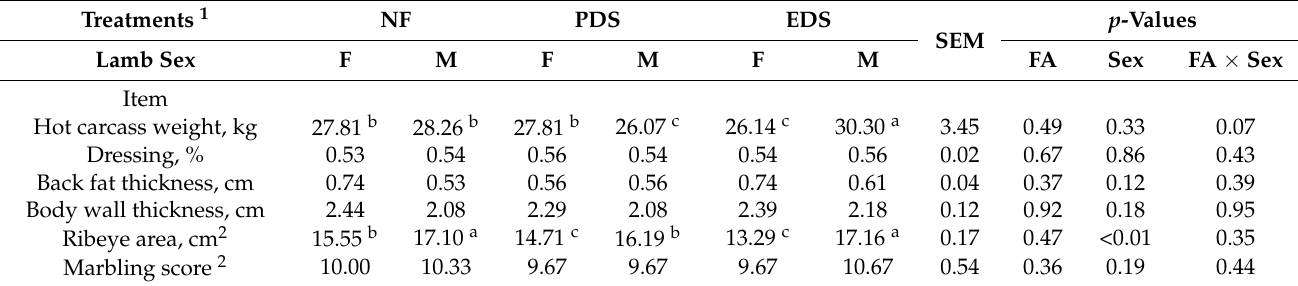
Table 8. Effect of a fatty acid enriched diet during the last 50 days of gestation on male (M) and female (F) lamb carcass